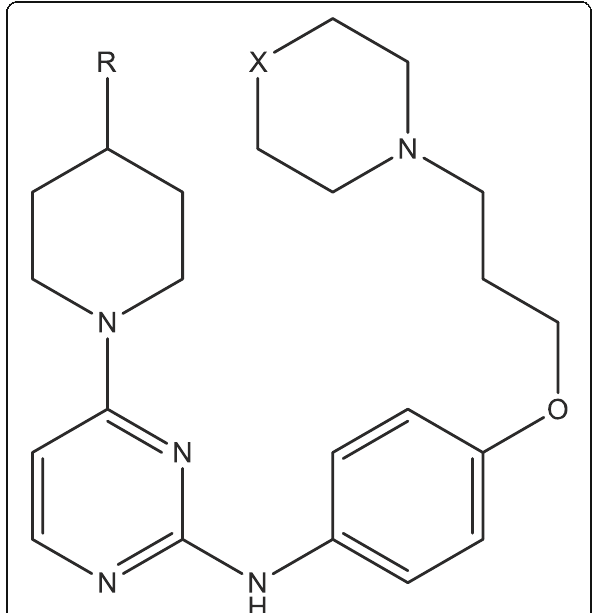
Fig. 1 Template of 2-anilinopyrimidine